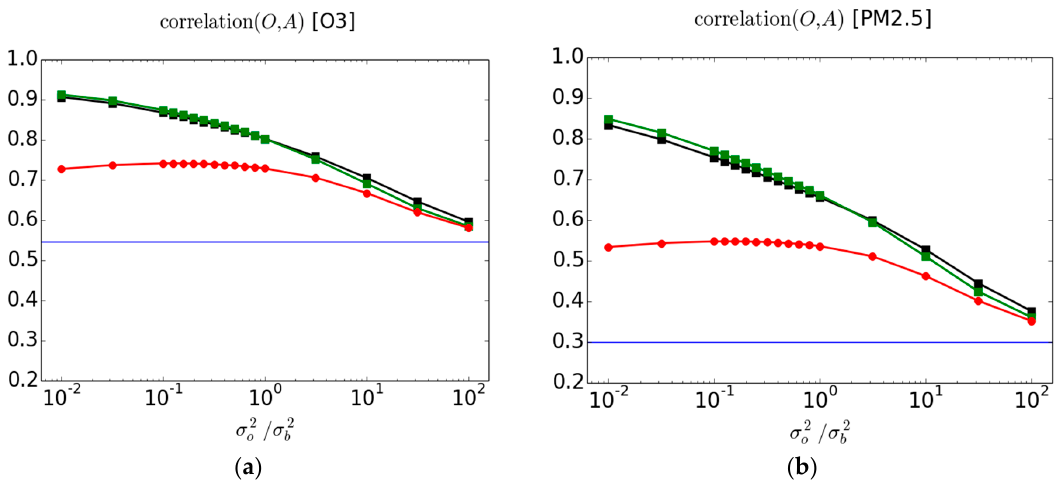
Figure 3. Correlation between observations and analysis for ( a ) O 3 and ( b ) PM 2.5 for both active and cross- validation passive observations as a function of 22 / bo σσγ= . The red, black and green curves are as in Figure 2.